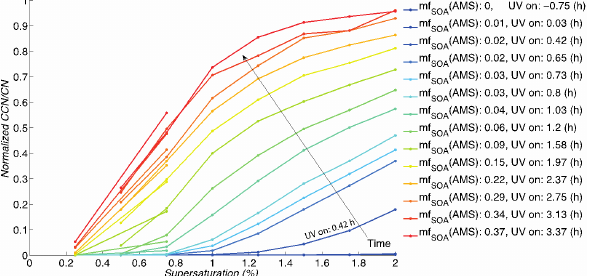
Figure 3. The evolution of the activation properties for the whole aerosol during the ageing event of experiment DEP3. Measurements from two CCNCs are overlapping in the range 0.25<supersaturation<0.75%, thereby are two lines visible for the low supersaturations. Before and just after the onset of UV expo- sure (UV on =− 0.75 and 0.03h respectively) almost no particles (<1%) are activated (dark blue) and the SOA mass ratio (mf SOA ) is close to zero. mf SOA (AMS) is estimated from measurements from the SP-AMS. As the soot particle acquires more organic material (mf SOA increase) the CCN properties improve. By the end of the experiment (UV on = 3.37h) all particles are activated (dark red) and mf SOA ≈